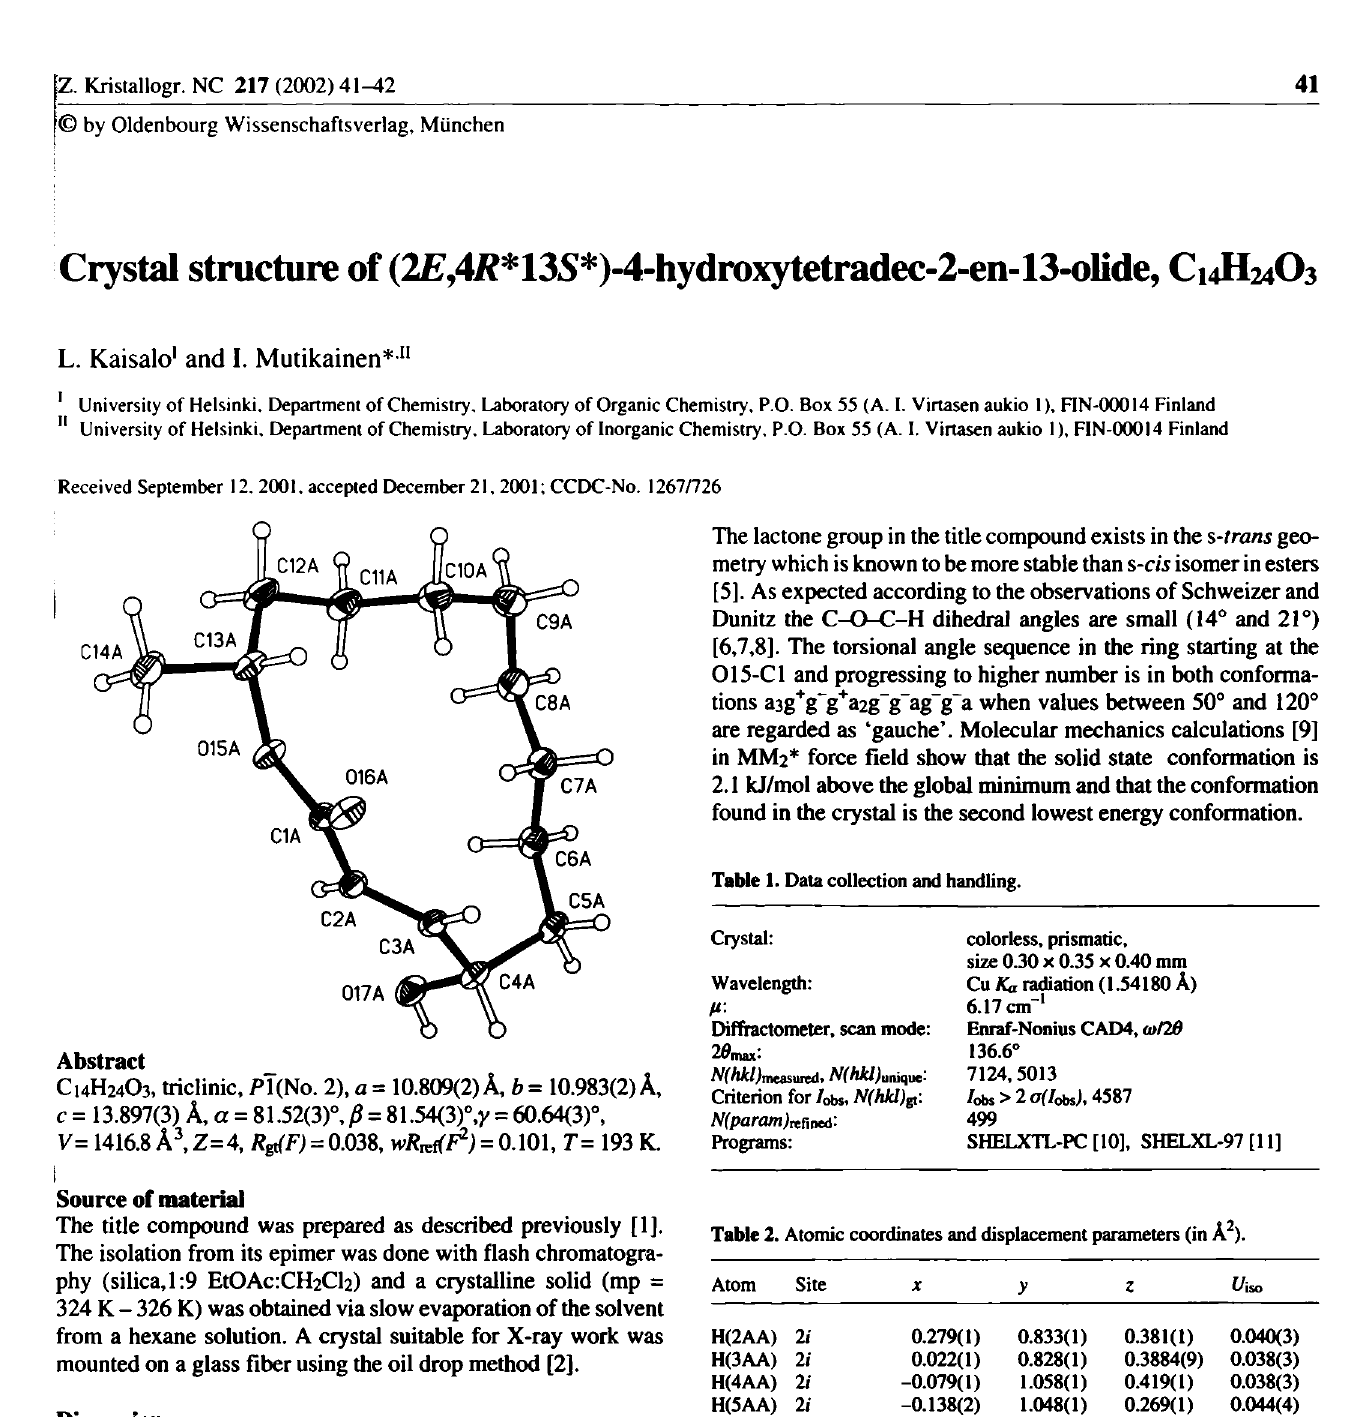
Table 2. Atomic coordinates and displacement parameters (in Â 2